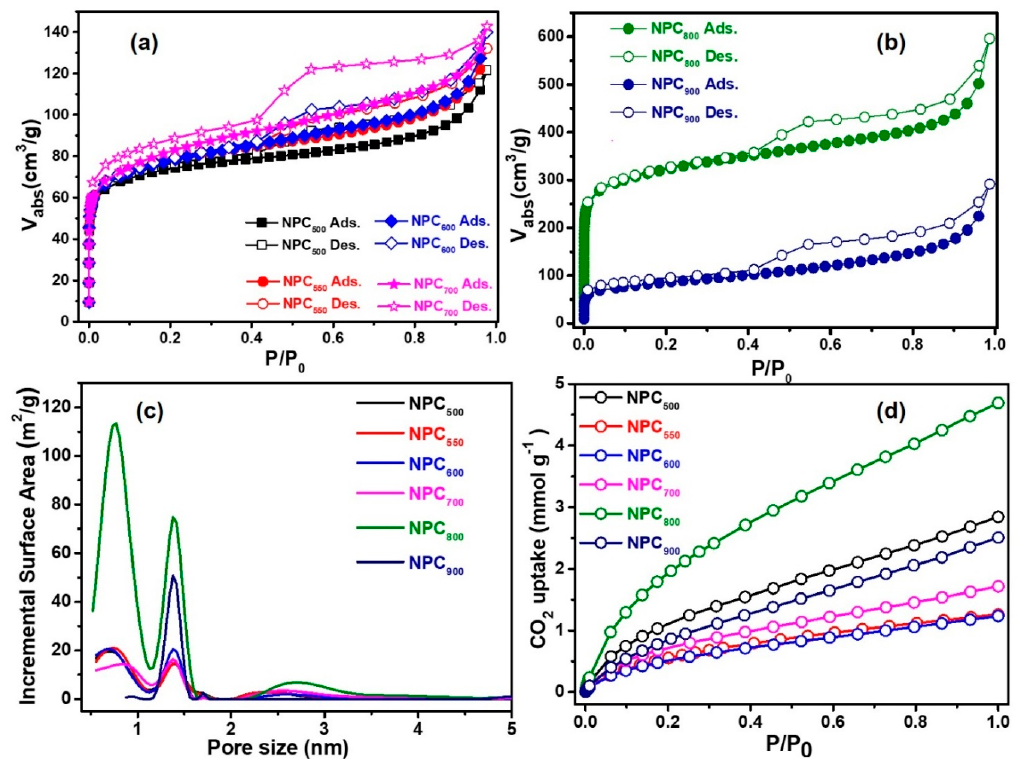
Figure 4. ( a,b ) N 2 sorption analysis at 77 K, ( c ) NLDFT pore size distribution profile and ( d ) CO 2 sorption isotherm at 273 K and 1 bar of NPC materials.